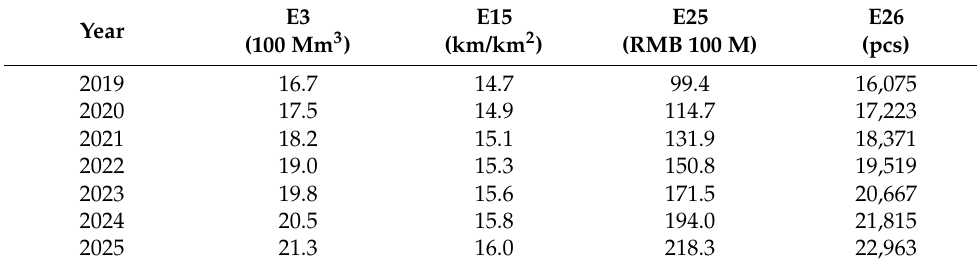
Table 8. Estimation results of each key indicator for potential